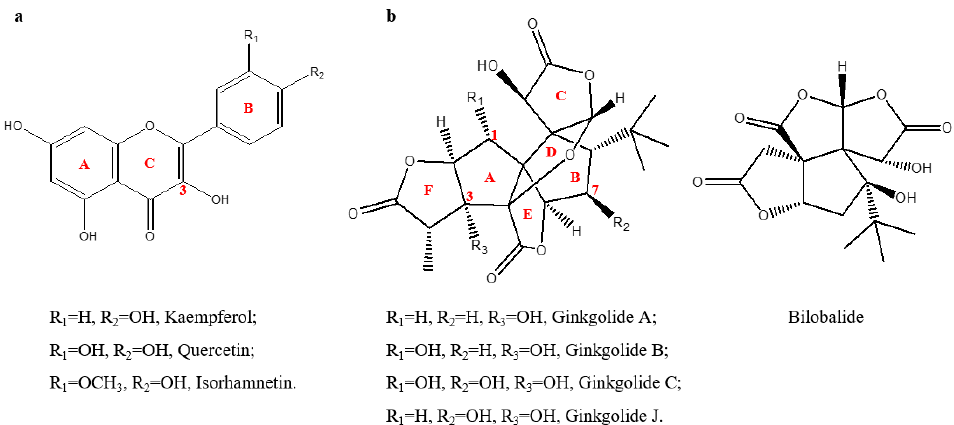
Figure 1. Structures of the major pharmacoactive ingredients in GBE. ( a ) Major flavonols (different glycosyls are usually linked at the 3-OH position). ( b ) Major terpene trilactones (ginkgolides and bilobalide). Structures were drawn using ChemDraw Ultra8.0 (CambridgeSoft, U.S.).